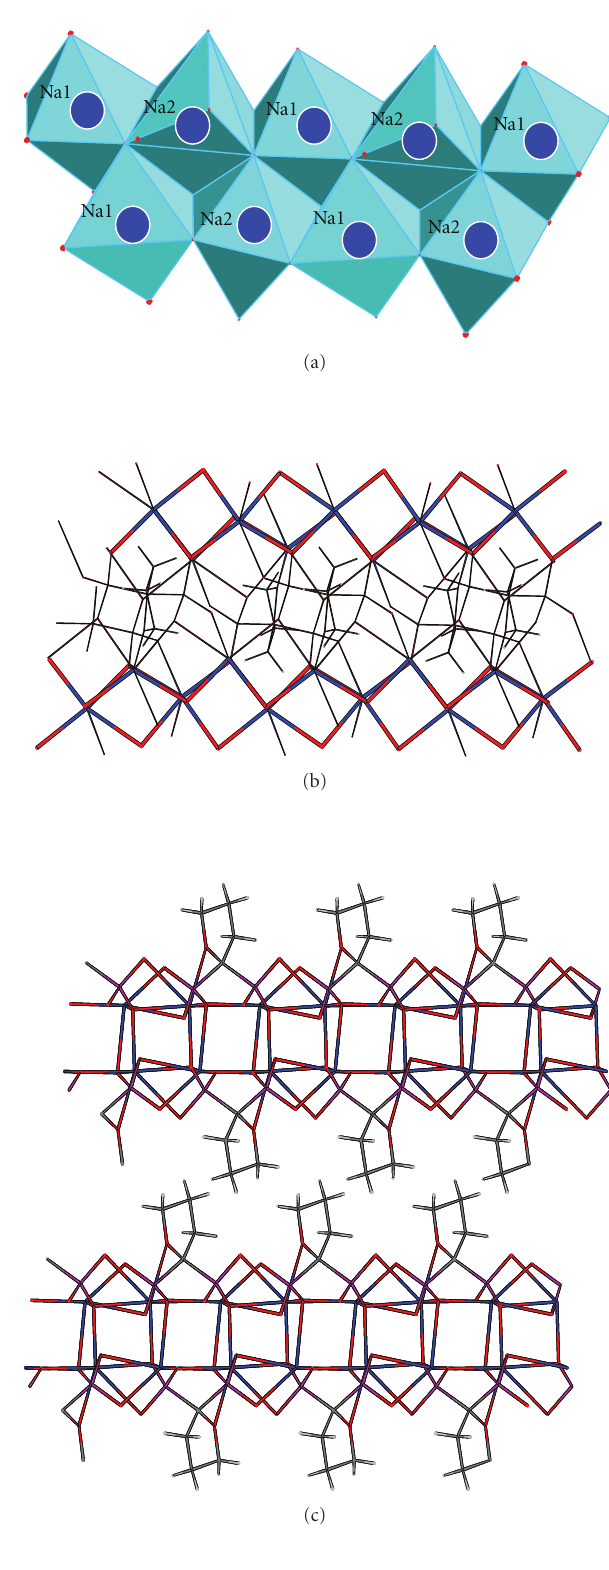
Figure 3: (a) Sodium-centered polyhedral connected to each other to form linear arrays along axis (1,1,0). (b) Connection of the linear sodium arrays with bisphosphonate anions to form two dimensional sheets. (c) Two layers stacked one parallel to the other along axis c